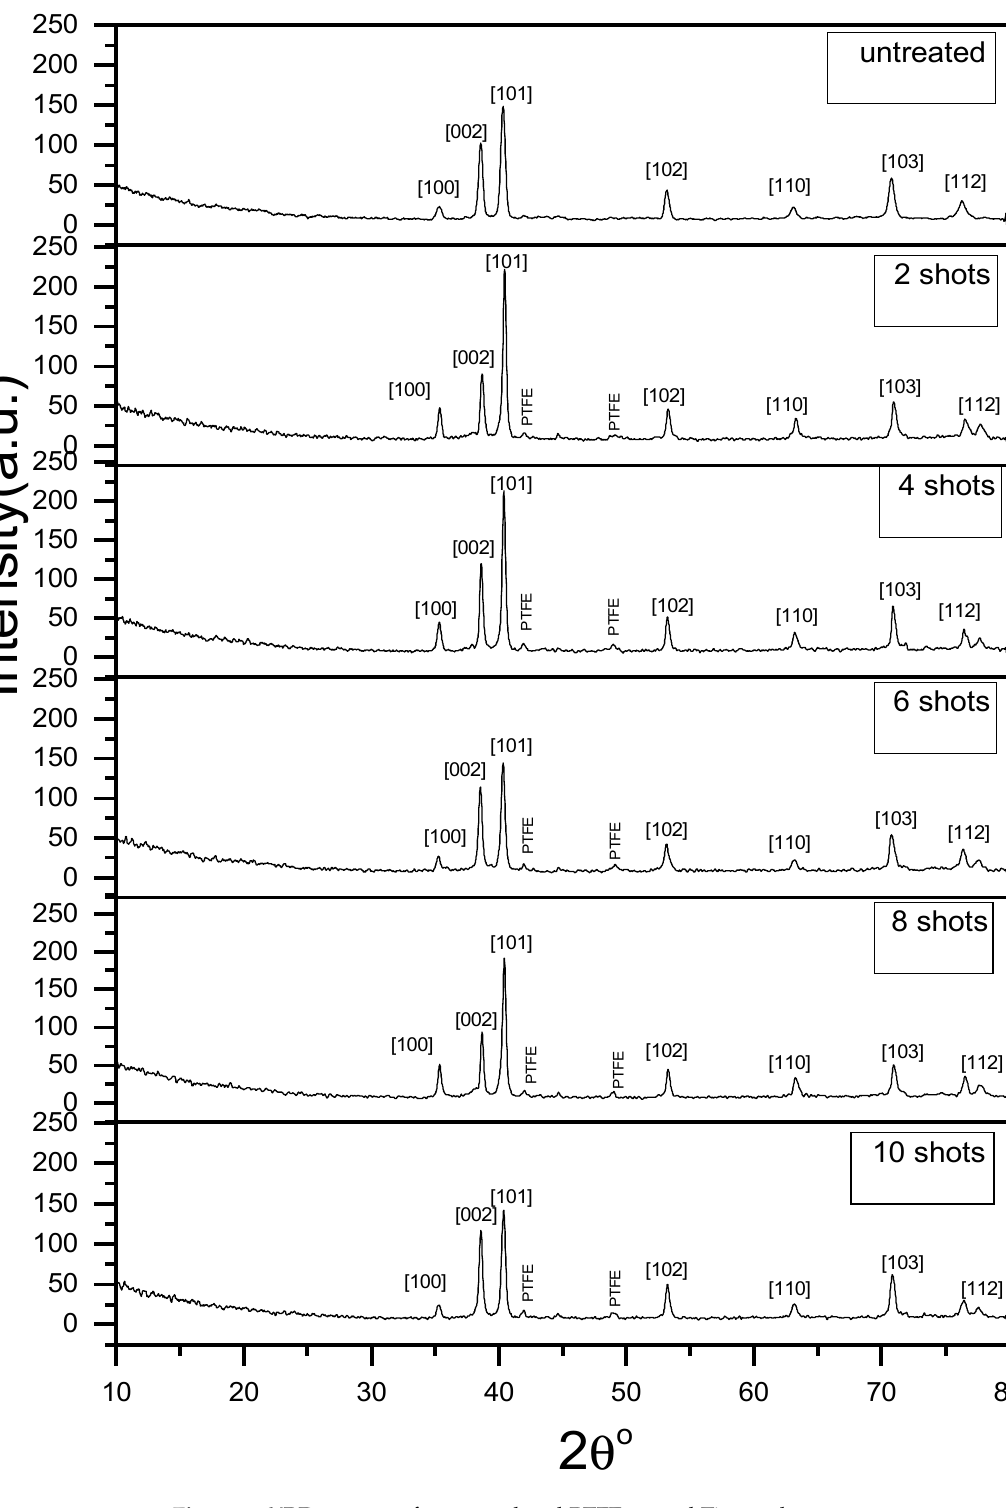
Figure 2. XRD pattern of untreated and PTFE-coated Ti samples. The main peaks corresponding to PTFE are located at 2 θ = 41.80° and 2 θ = 48.90°. Peaks, due to titanium and PTFE, are observed at 2 θ = 70.89° and 2 θ = 76.61° simultane- ously [27]. PTFE peaks for two shots are broader and do not resolve precisely. Initially, for a smaller number of shots, smaller PTFE clusters are induced in the Ti matrix. The results can be easily seen in the spectra of the samples exposed for 2, 4, 6, 8 and 10 focus